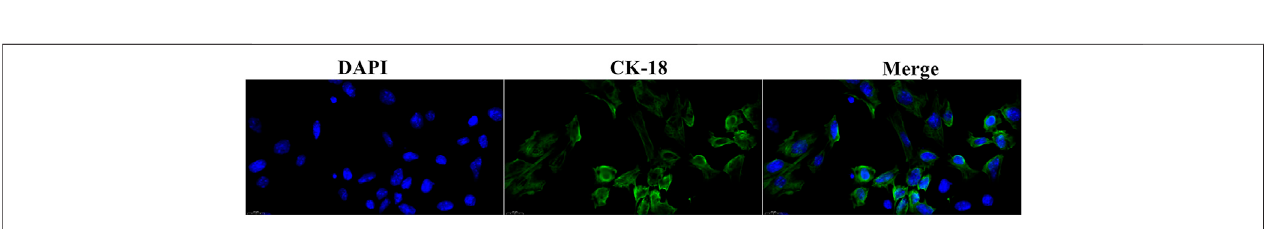
FIGURE 5 | Cell biological detection. The nucleus was dyed blue. The cytoplasm was dyed green by CK-18.